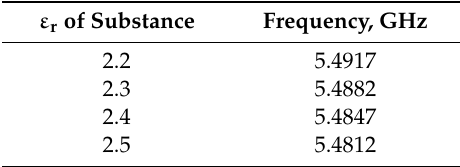
Table 1. Simulated results pertaining to the second resonance when the substance permittivity was varied.